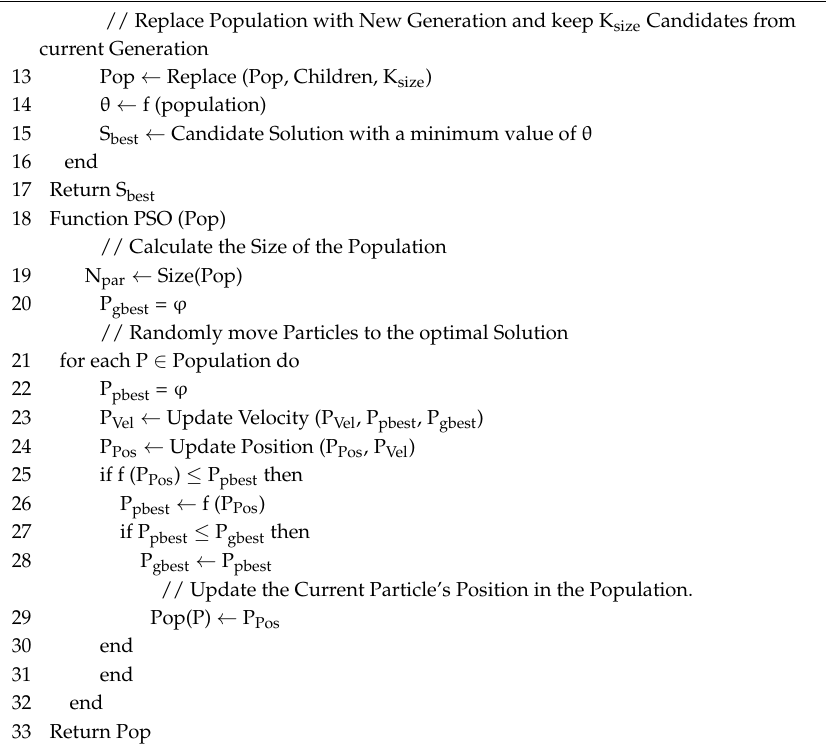
Algorithm 1. Algorithm for Obtaining Optimal Load Shed